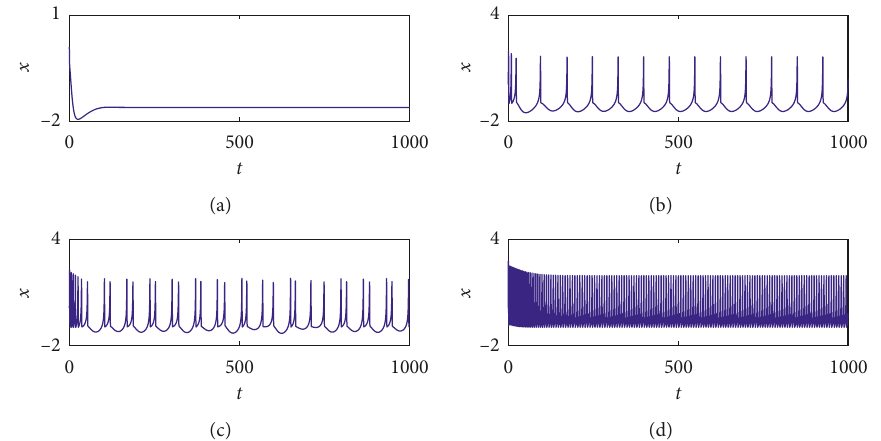
Figure 2: Time series of x variable of the HR neuron. For (a) quiescent state with I � 0; (b) spiking firing with I � 2; (c) bursting firing with I � 3; (d) periodical firing with I � 6. The initial values are selected with (0.1, 0.01, 1.05).